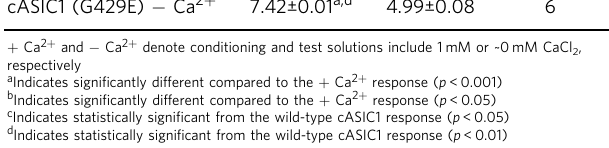
+ Ca 2 + and − Ca 2 + denote conditioning and test solutions include 1mM or ~0mM CaCl 2 , respectively a Indicates signi fi cantly different compared to the + Ca 2 + response ( p <0.001) b Indicates signi fi cantly different compared to the + Ca 2 + response ( p <0.05) c Indicates statistically signi fi cant from the wild-type cASIC1 response ( p <0.05) d Indicates statistically signi fi cant from the wild-type cASIC1 response ( p